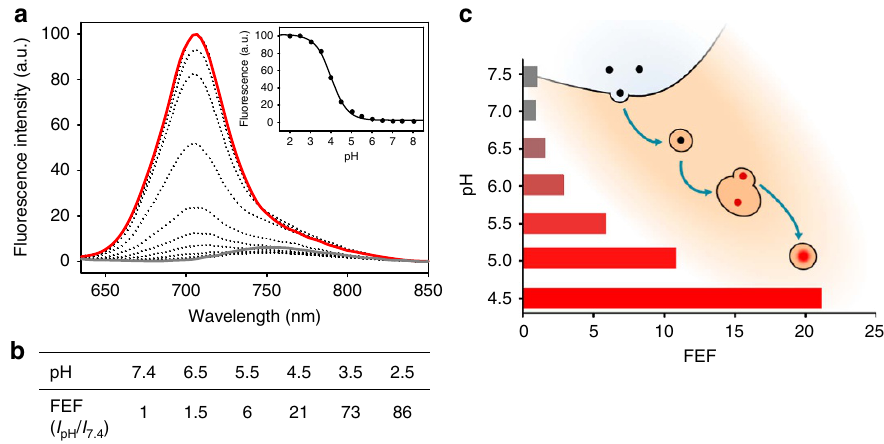
Figure 4 | Cellular uptake responsive NIR-fluorescence. ( a ) Emission spectra of 2 (5 (cid:3) 10 (cid:2) 6 M) in DMEM (10% FBS) at pH ranging from 8 (grey) to 2 (red). Exc: 625nm. Inset: fluorescence intensity at l max ¼ 707nm versus pH; sigmoidal plot fit resulted in apparent p K a ¼ 4.0. ( b ) Corresponding FEF values from differing pH solutions applying Cy5.5 filter parameters. ( c ) Diagram represents the pH changes and increasing fluorescence intensity along endocytic path towards lysosomes.